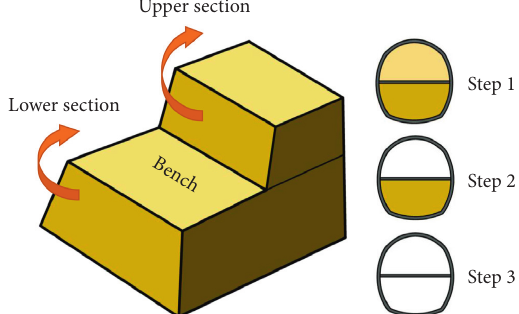
Figure 4: Bench excavation method.